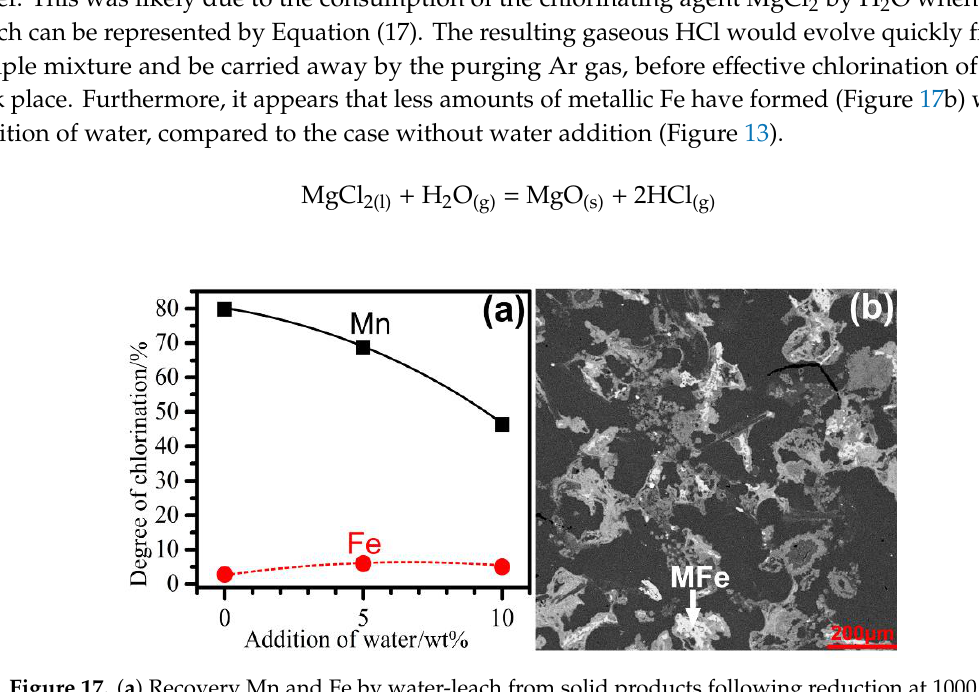
Figure 17. ( a ) Recovery Mn and Fe by water-leach from solid products following reduction at 1000 °C with the addition of 20 wt% CaCl 2 , 40 wt% MgCl 2 and varying amounts of water, and ( b ) BSE image of the reduced product with the addition of 10 wt% water (MFe: metallic Fe).